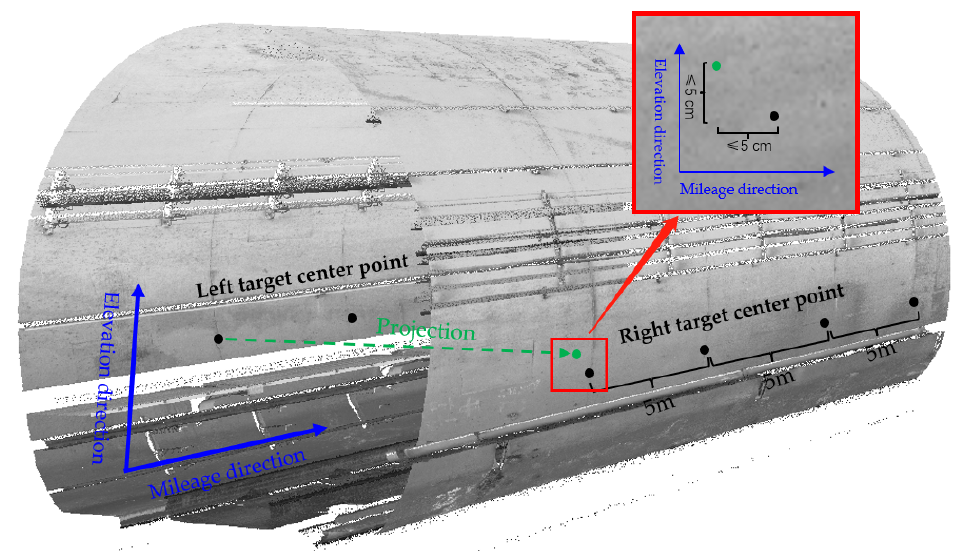
Figure 3. Target layout.